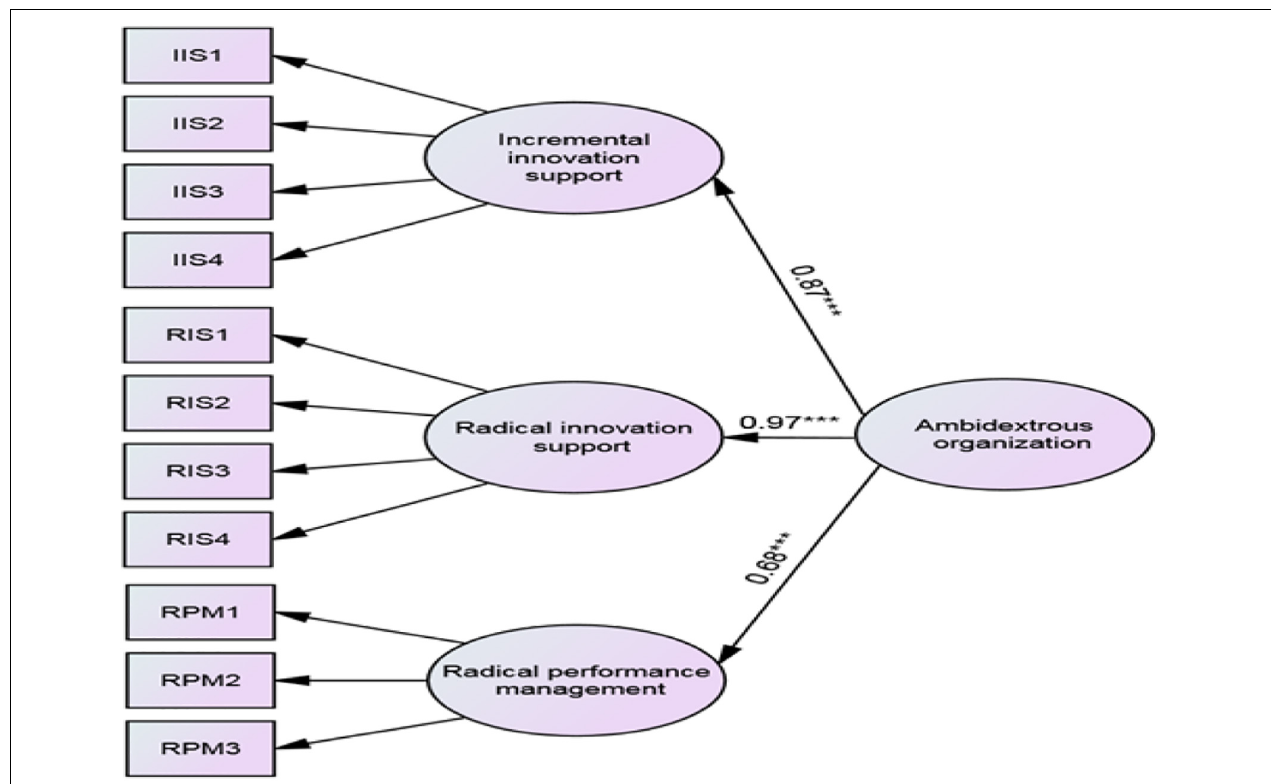
FIGURE 2 | Model 4: Three first-order factors, one second-order factor. *** Significant at the 0.001 level (Two-tailed test). TABLE 5 | Measurement model for three first-order latent factors and one second-order latent factor.